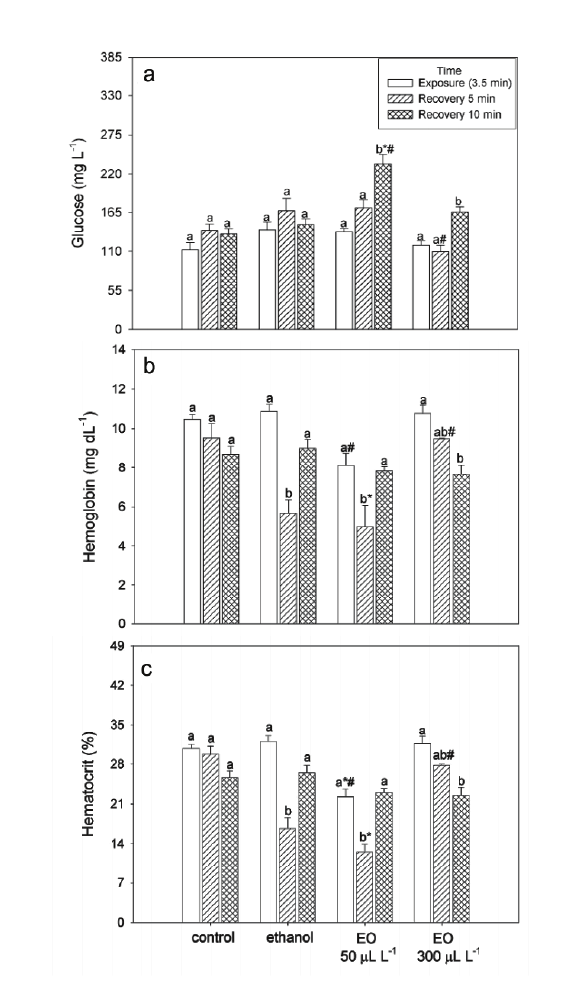
Figure 1 - Glucose ( a ), hemoglobin ( b ) and hematocrit ( c ) levels in Epinephelus marginatus after exposure to essential oil (EO) of Aloysia polystachya added to the water (n = 6). Values are represented as mean ± SEM. Different letters indicate significant differences between times in the same treatment (P < 0.05). * indicates significant difference from the control group at the same time and # indicates significant difference from the ethanol group at the same time (P < 0.05).